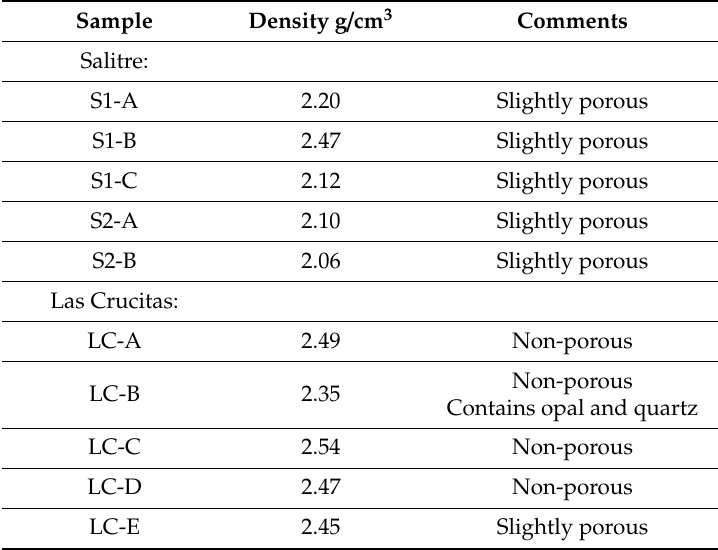
Table 1. Density of fossil